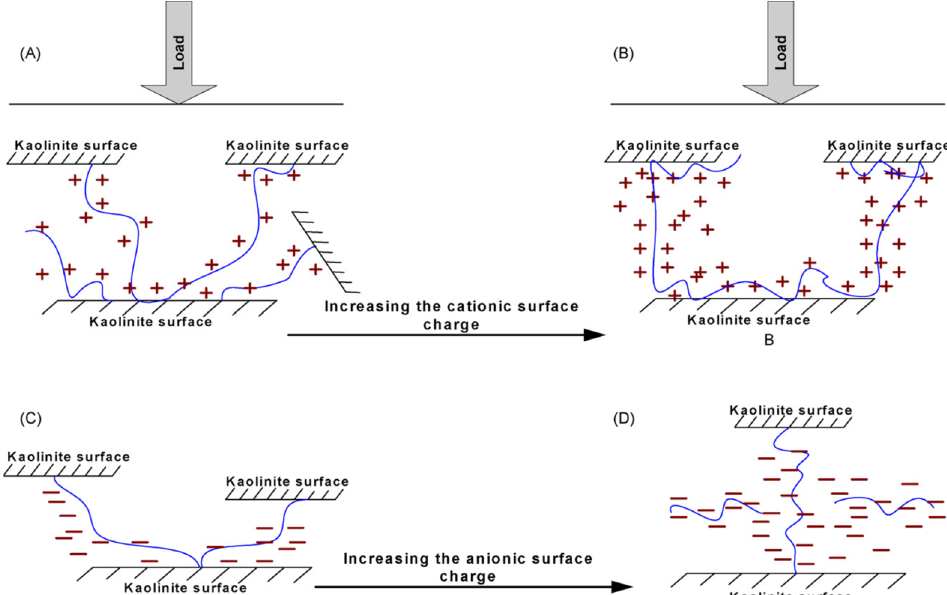
Figure 2. The effect of charge density on the bridging mechanism and adsorption rate in flocculation of kaolinite suspension using anionic polyacrylamides (PAM) of similar molecular weight: ( A , B ) the increase of cationic PAM led to the dominance of strong adsorption and loss bridging; ( C , D ) anionic PAM caused the decrease in the adsorption rate due to the increased electrostatic repulsion between the negatively PAM chains and the negative kaolinite surface. (Reproduced from Nasser et al. (2007)